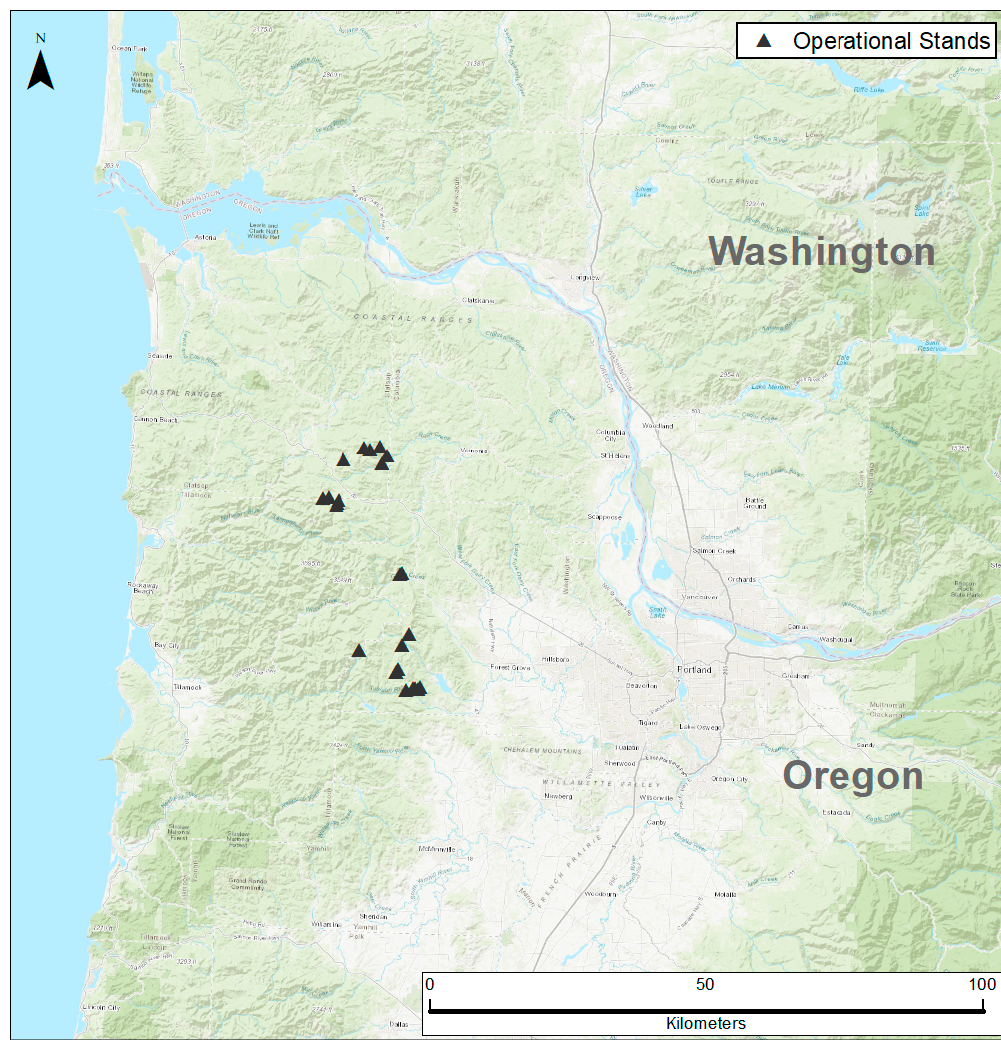
Figure 1. Location of the twenty-three operational stands within Stimson Lumber Company (SLC) ownership in the northern Coast Range of western Oregon.